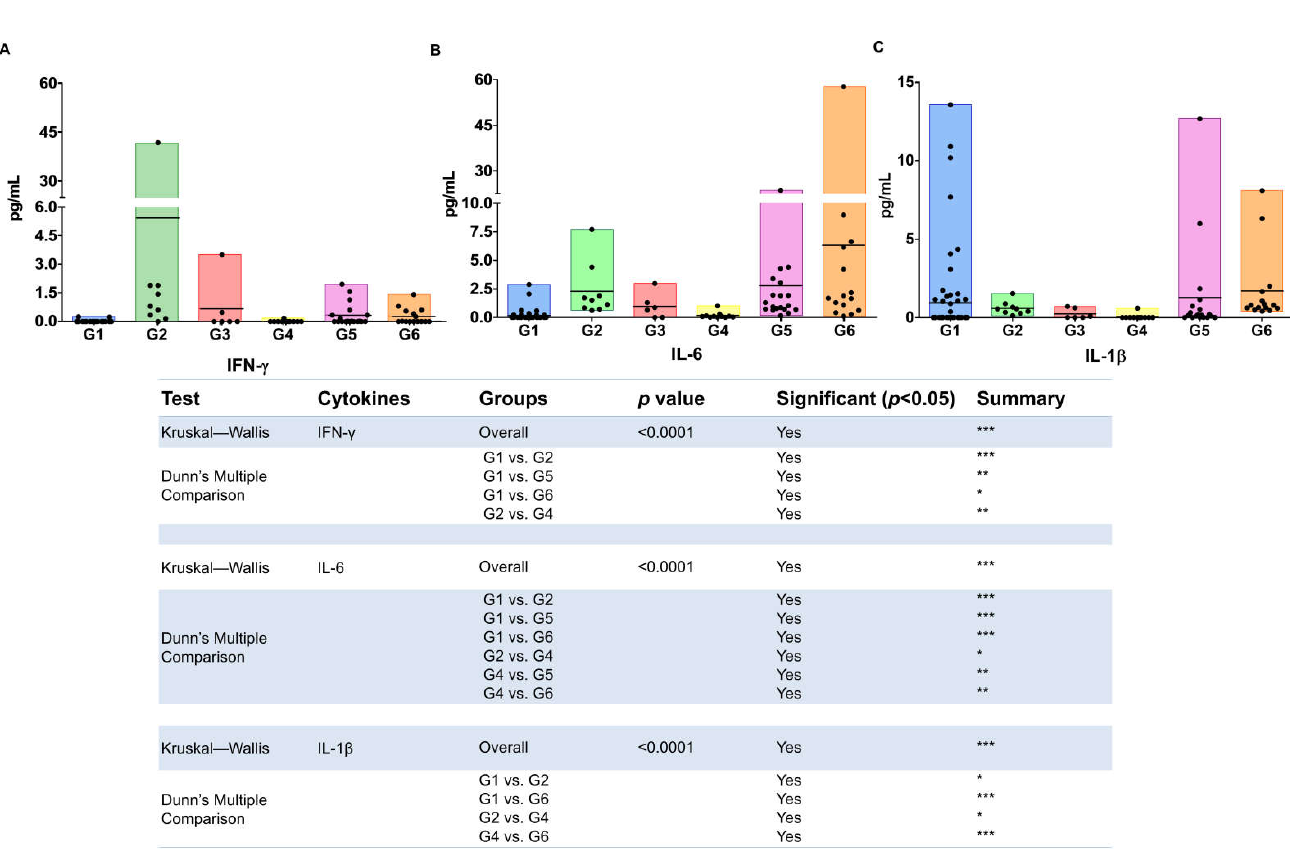
Figure 2. Levels of cytokines detected in plasma samples of HIV-infected and HTLV-1-, HTLV-2-, and/or HCV-co-infected patients. G1 (HIV), G2 (HIV/HTLV-1), G3 (HIV/HTLV-2), G4 (HIV/HCV), G5 (HIV/HCV/HTLV-1), G6 (HIV/HCV/HTLV-2). Subfigures A , B and C refer to the values of IF-γ, IL-6, and IL-1β quantification, respectively. The horizontal line inside the bars denotes mean values. Differences statistically significant are depicted using the Kruskal–Wallis analysis of variance (ANOVA) complemented with Dunn’s multiple comparison test. p -values depicted as asterisks correspond to: * p < 0.05; ** p ≤ 0.01; *** p ≤